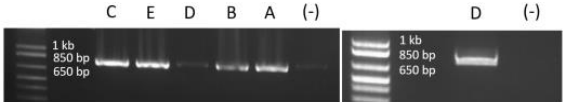
Figure 2. Long-range PCR results showing the amplified fragment containing the breakpoint junction of the exon 49 deletion, using Q5 High-Fidelity DNA Polymerase. We note that we have the same 750 bp fragments for the 5 individuals. All patients are identified by the same letter as in the text. (-) signs mark the negative control lanes (PCR amplification without DNA). For patient D (daughter of patient E), PCR had to be redone using a new source of DNA because of the degradation of the first source.